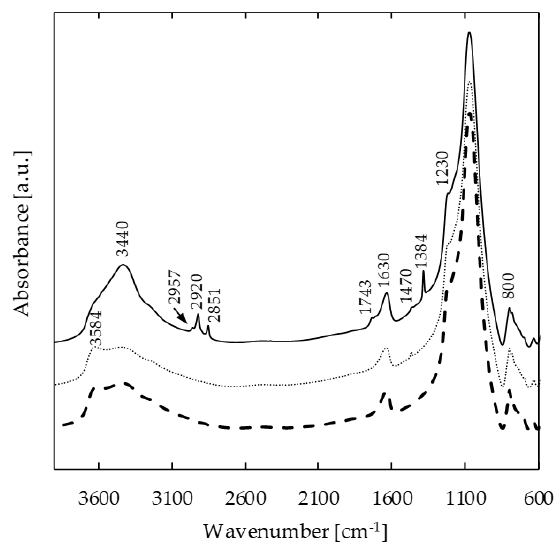
Figure 1. In situ FTIR spectra of acidic transformed natural zeolite (AZ) samples: uncovered AZ sample (dashed line); AZ sample saturated with toluene (dotted line); AZ sample after catalytic ozonation (solid line).